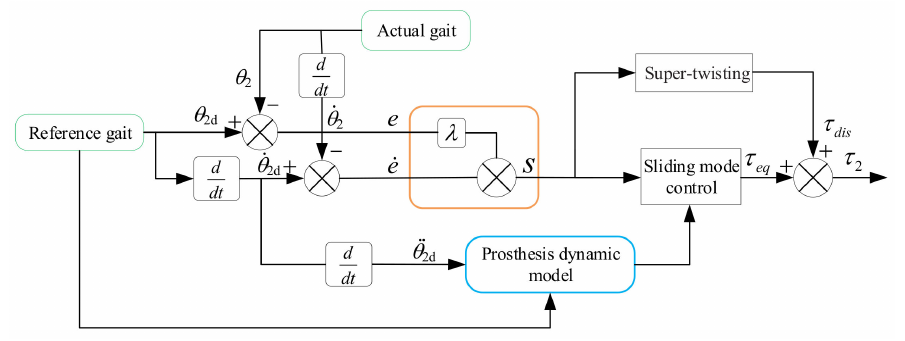
Figure 15. SOSMC principle